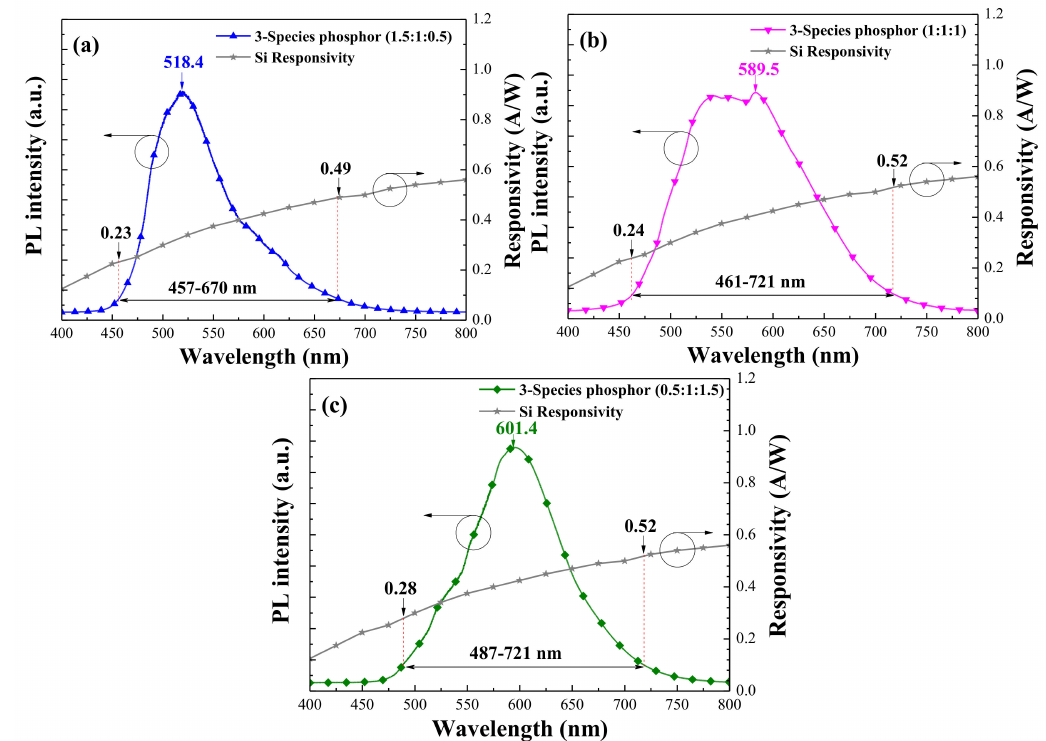
Figure 3. Photoluminescence (PL) emission spectra of LDS layer that included combinations of specie-A/specie-B/specie-C Eu-doped phosphors at (A:B:C) concentration ratios of ( a ) 1.5:1:0.5 ( b ) 1:1:1, and ( c ) 0.5:1:1.5 in wt %. Table 1. Emission peaks, emission wavelength range at 10% of maximum PL intensity, and responsivity at the emission wavelength range of 10% of maximum PL intensity in all samples. Combination of Eu-Doped